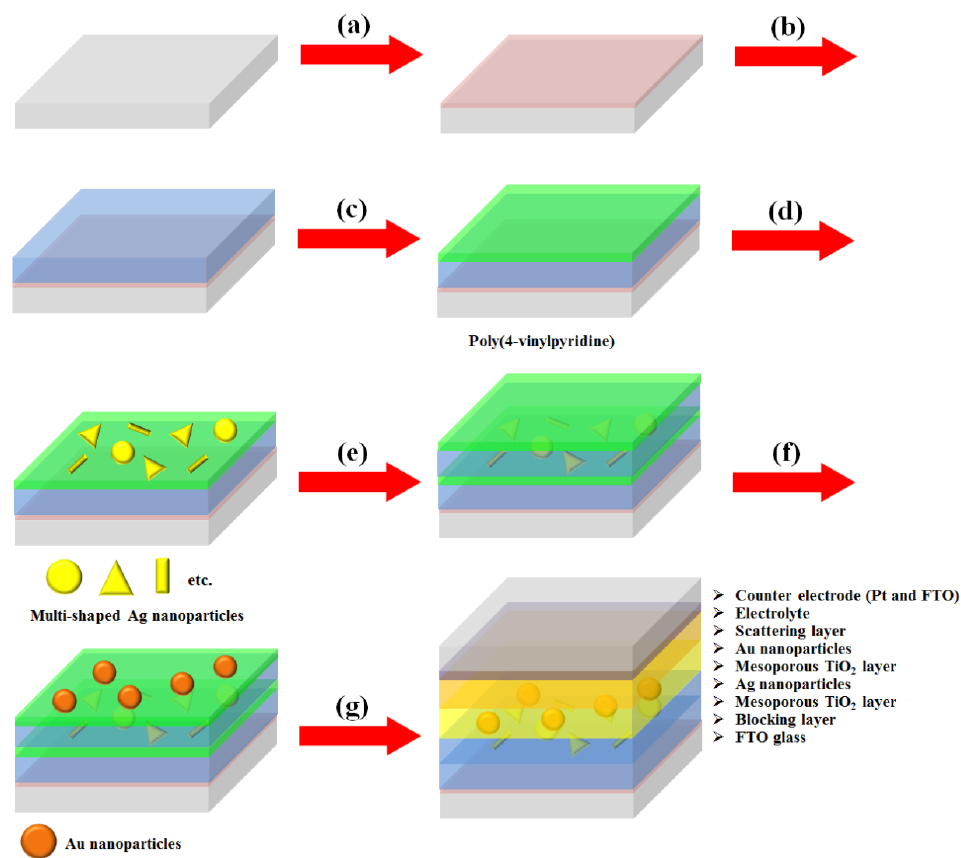
Figure 1. Fabrication process of DSSCs based on the layer-by-layer structure with multi-shaped Ag and Au nanoparticles (NPs): ( a ) coating of the TiO 2 blocking layer; ( b ) coating of the mesoporous TiO 2 layer on the TiO 2 blocking layer; ( c ) coating of the poly(4-vinylpyridine) on the mesoporous TiO 2 layer;( d ) immobilization of the multi-shaped Ag NPs; ( e ) recoating of the mesoporous TiO 2 layer and poly(4-vinylpyridine); ( f ) immobilization of the Au NPs; and ( g ) fabrication of the DSSC.